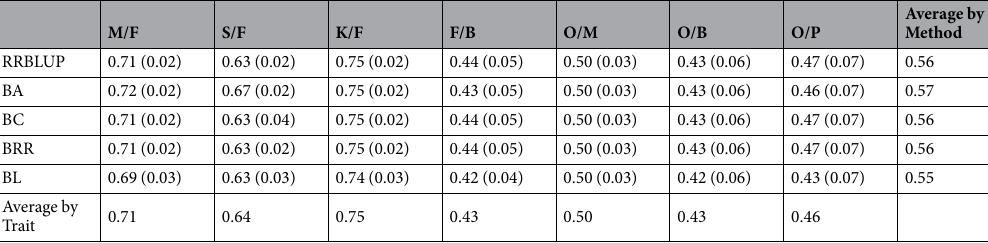
Table 1. Prediction accuracy (with standard deviation in brackets) for 7 traits based on RR-BLUP and Bayesian methods.